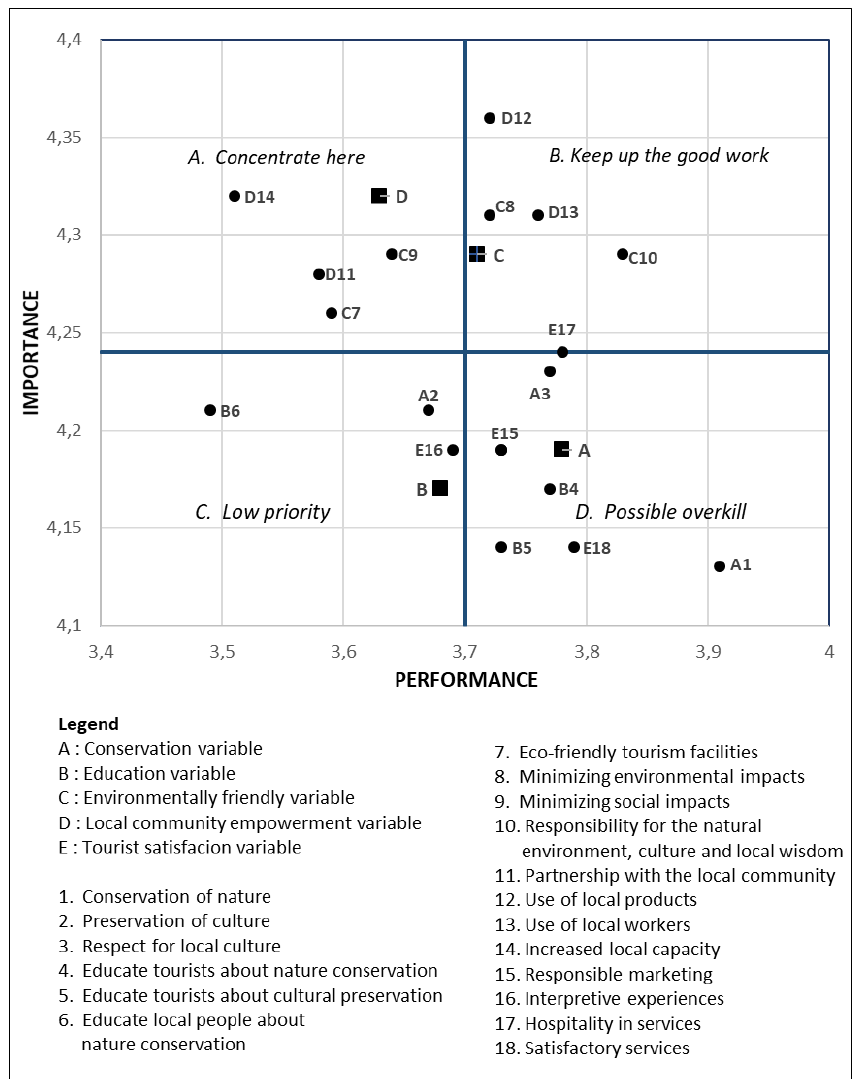
Figure 1: Importance-Performance Analysis of the attributes of ecotourism principles in the diving tourism practices in Bali